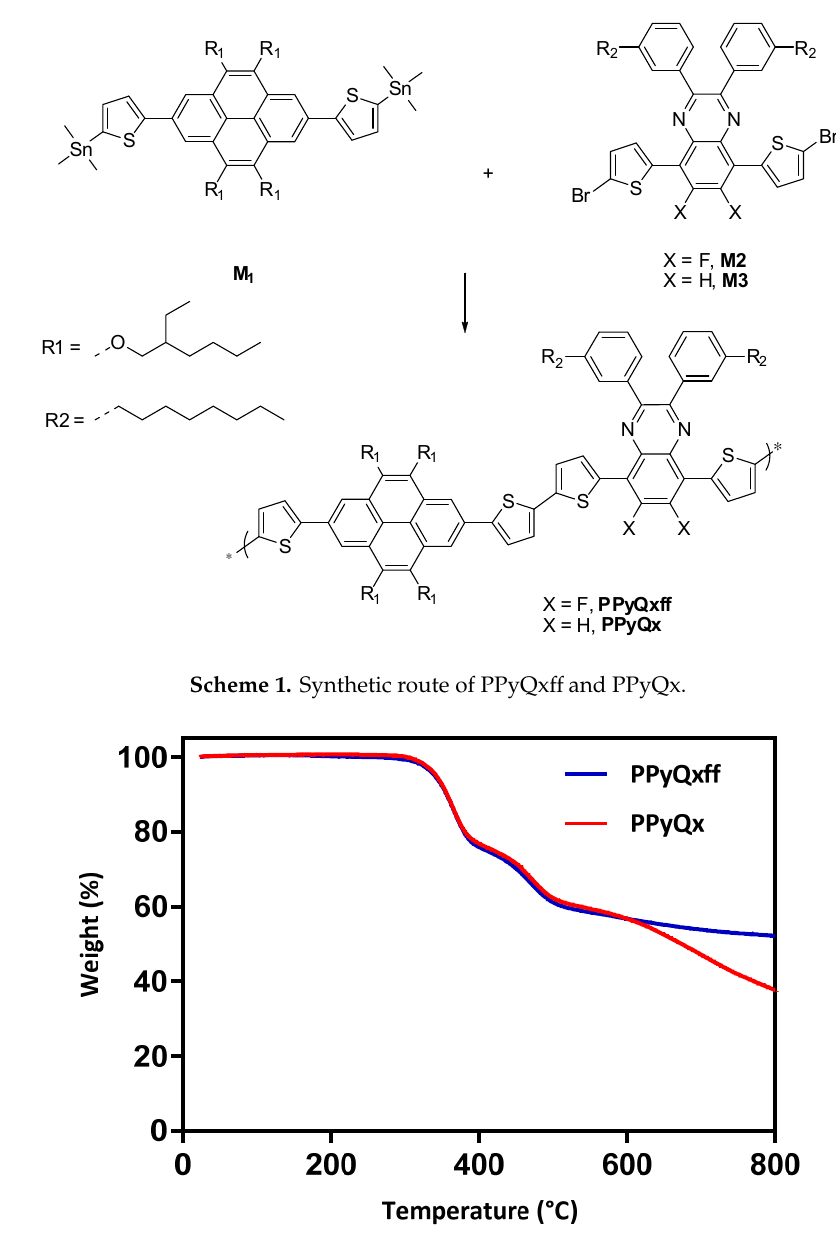
Figure 1. TGA curves of (PPyQxff) and (PPyQx).